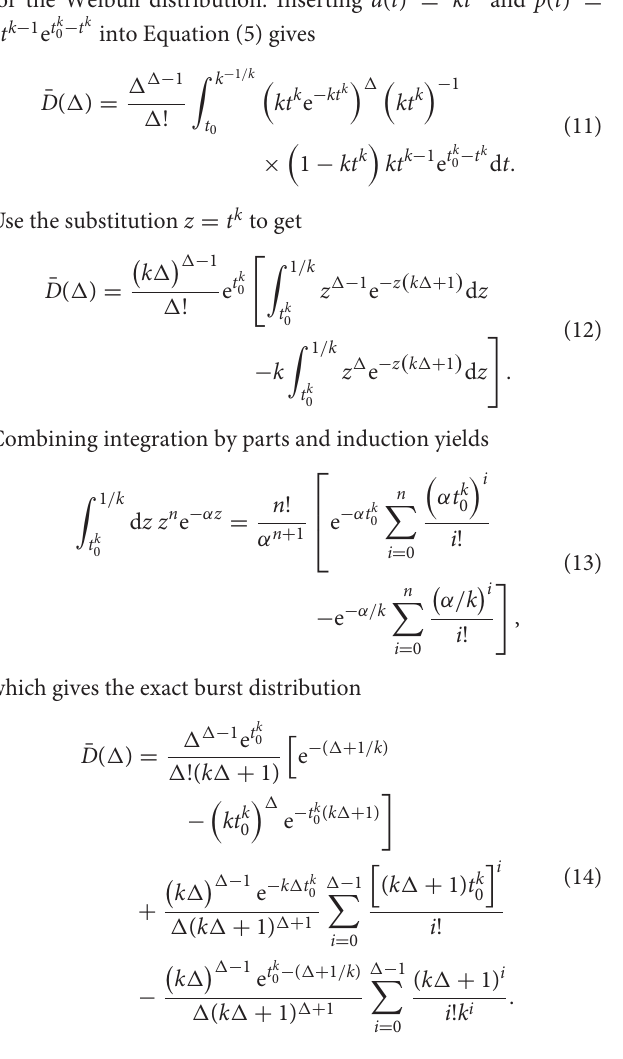
FIGURE 1 | Burst distribution ¯ D ( 1 ) for a Weibull threshold distribution with k 2 and t 0 0. The exact result (black) is Equation (14) and the asymptotic = = result (red) is Equation (4). The simulation results (turquoise) were found by averaging ¯ D ( 1 ) over 10 6 sample systems with N